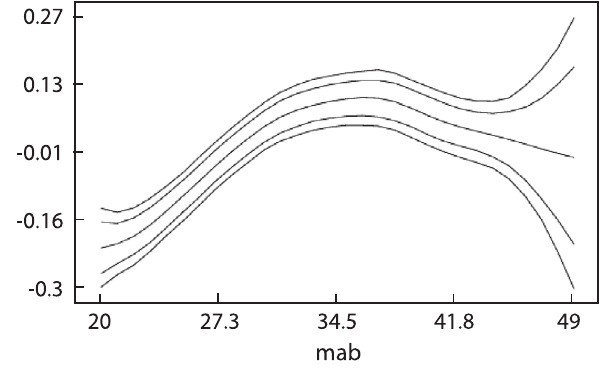
Figure1: Nonlinear effect of mother’s age at birth (mab) on